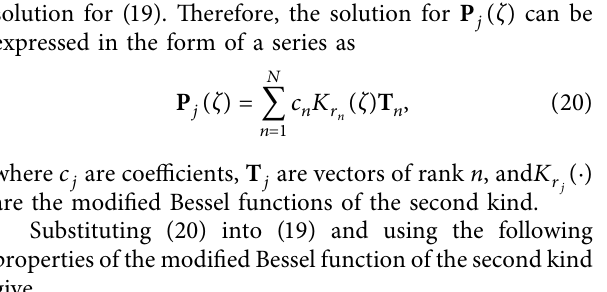
Figure 11: The variation in the ratio ω different values of δ